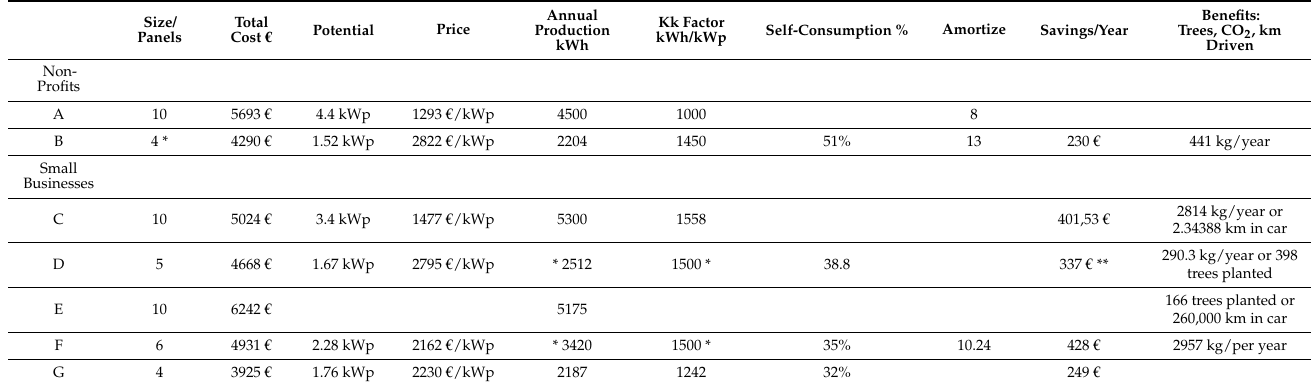
Table 3. Data collected from actual solar PV installation proposals for a midsize apartment in Madrid solicited from home solar providers and installers in March 2021. (* We inserted a common Kk factor of 1500 KWh/KWp to calculate annual production where it was not provided. ** We divided the proposed 10-year savings of 3370 € to an average of 337 € annually to provide clearer comparisons with other